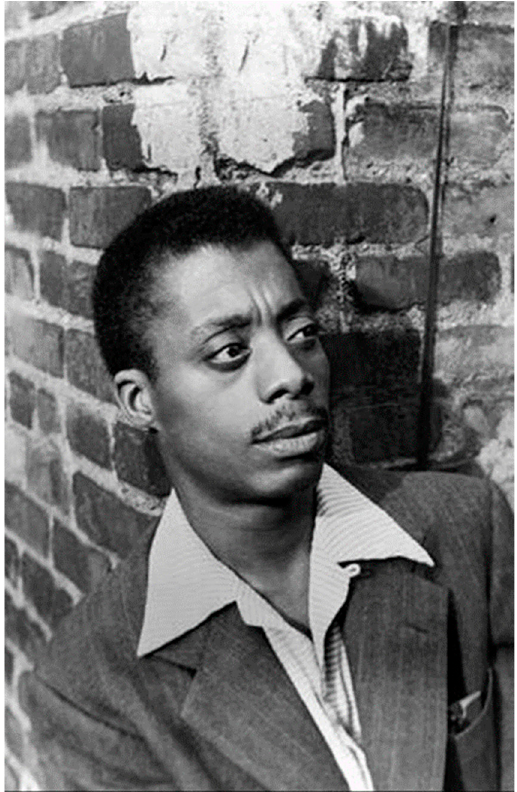
Figure 2. Courtesy: CSU Archives/Everett Collection via Alamy.